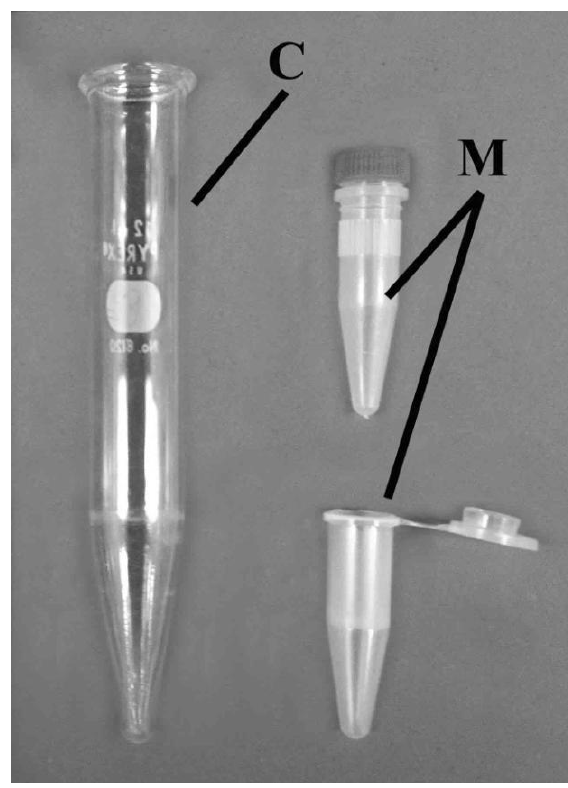
F IGURE 3. A glass, 12 ml centrifuge tube (C), and two micro-centrifuge tubes (M) used for